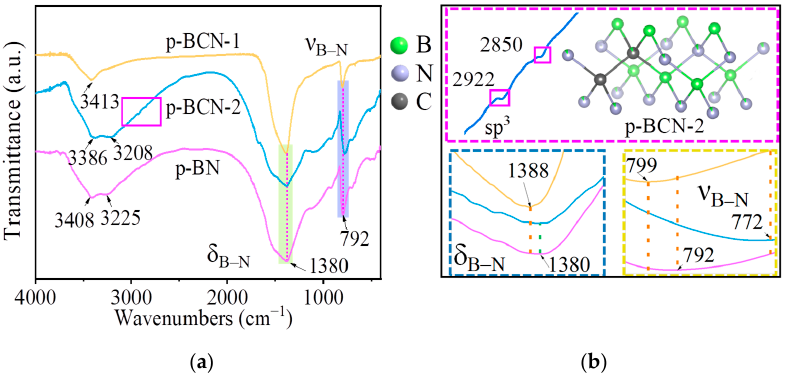
Figure 6. ( a ) FTIR spectra of p-BN, p-BCN-1, and p-BCN-2. ( b ) An enlarged view of the FTIR spectra of p-BCN-2 in the range of 3000~2400 cm − 1 (rose rectangle), an enlarged view of the FTIR spectra of the light green rectangle in the range of 1500~1300 cm − 1 , and the light purple rectangle in the range of 820~760 cm − 1 in ( a ).